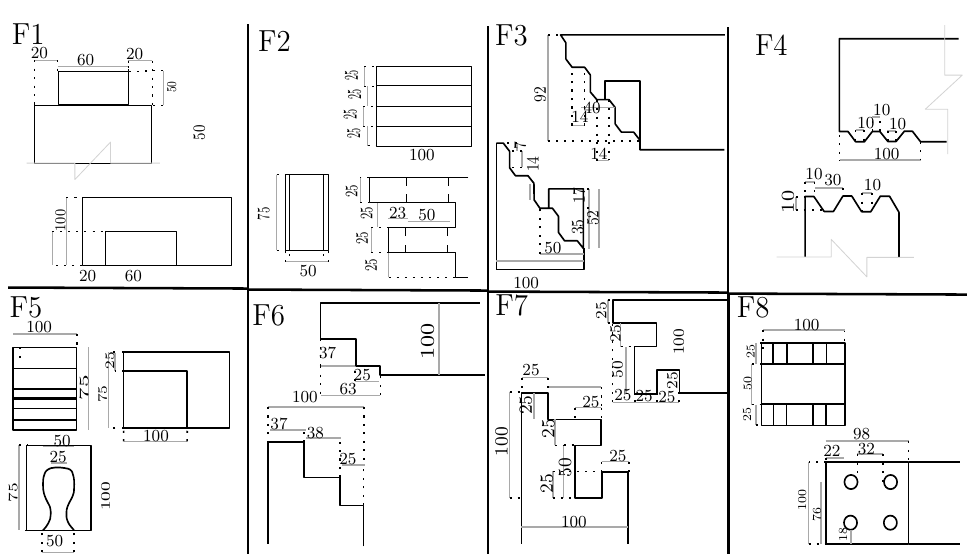
Figure A1. The details of selected dry